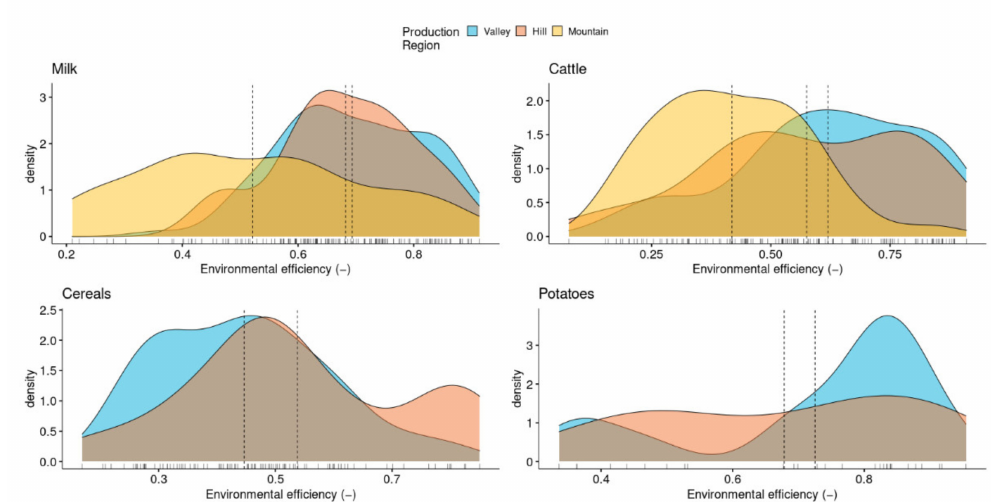
Figure 5. Differences in effects of production region on environmental efficiency. The dotted line marks the average environmental efficiency for the product group–production region combination. The tick marks below the x -axis denote actual